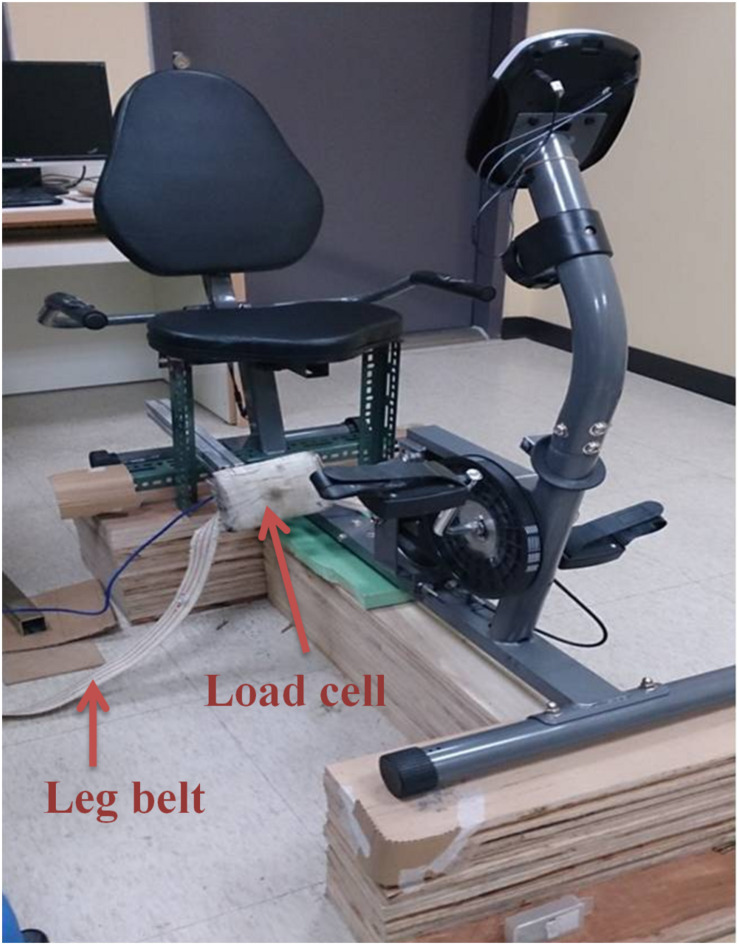
The cycling force measurement system (belts for fixing hips and trunk are not shown).